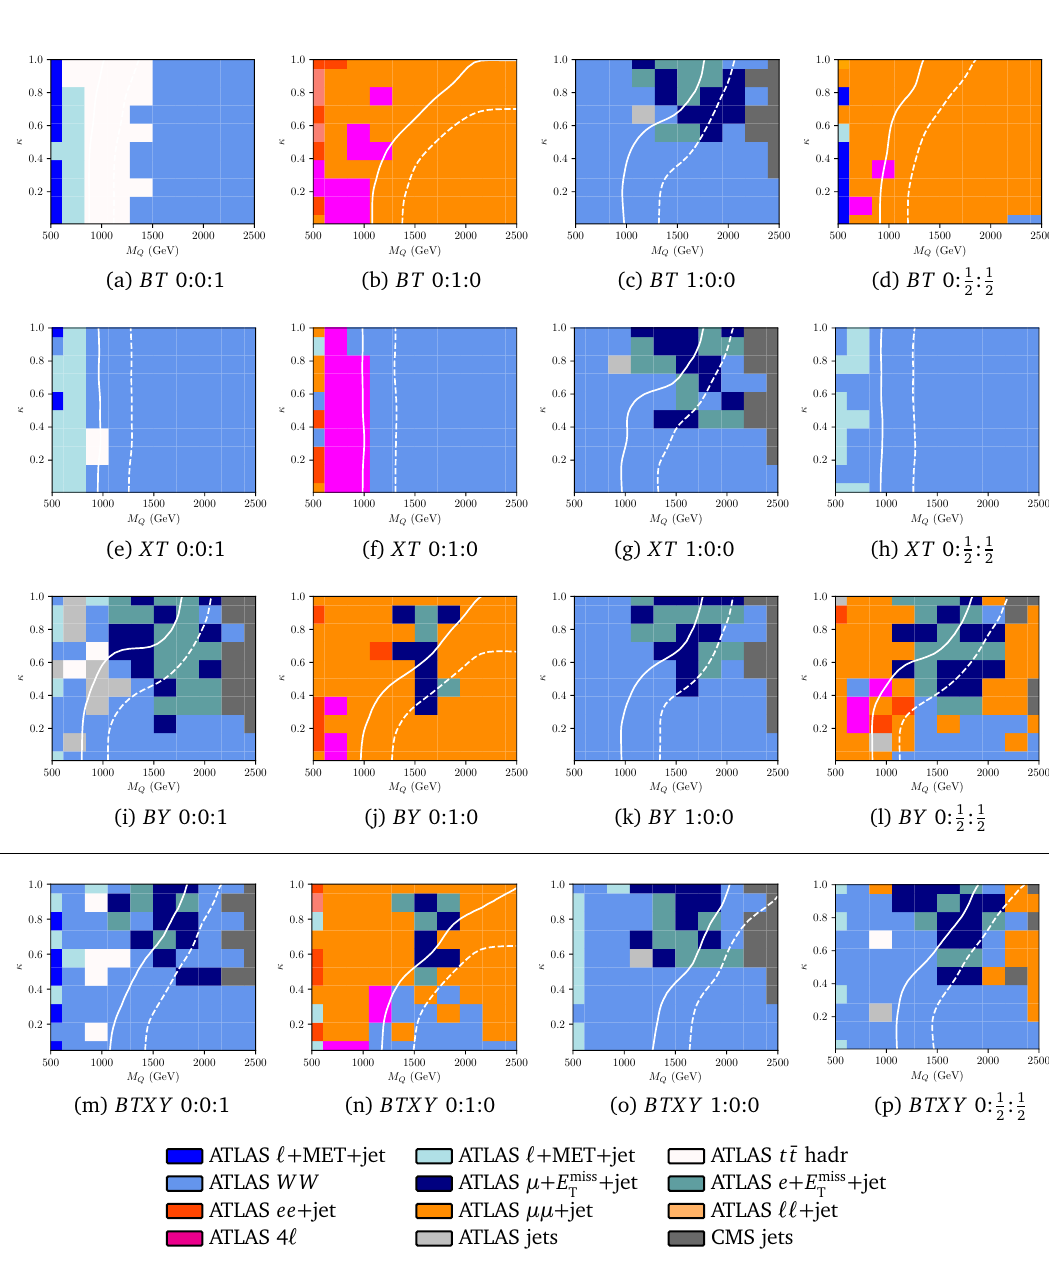
Figure 18: Sensitivity of LHC measurements to VLQ doublet production in the κ vs VLQ mass plane, where κ is the coupling to third-generation SM quarks. All VLQ masses are set to be degenerate. The multiplets are given as rows: (a)–(d)( B , T ) doublet, (e)–(h)( X , T ) doublet, (i)–(l)( B , Y ) doublet, and for comparison to the main text, the (m)–(o)( B , T , X , Y ) quadruplet. The VLQ branching fractions to W : Z : H are arranged in columns of 0:0:1, 0:1:0, 1:0:0, and 0: 1